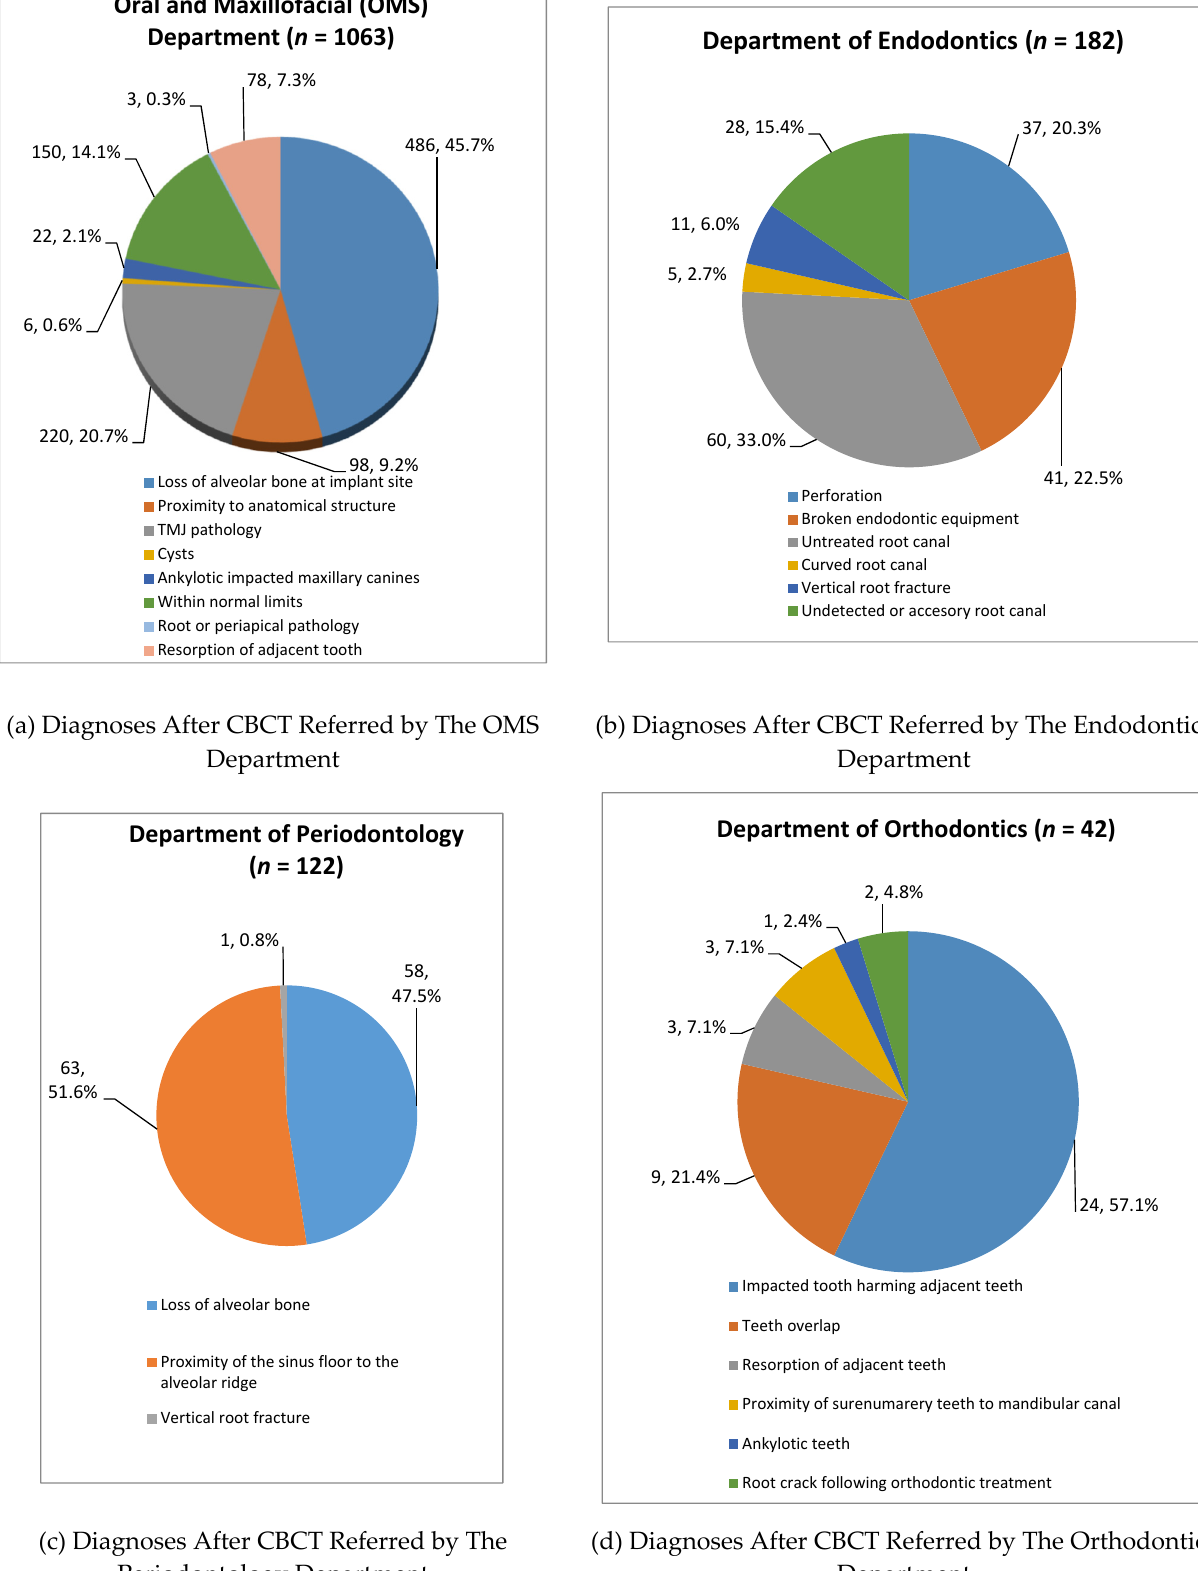
Figure 3. Final Diagnoses According to The Referring Department.